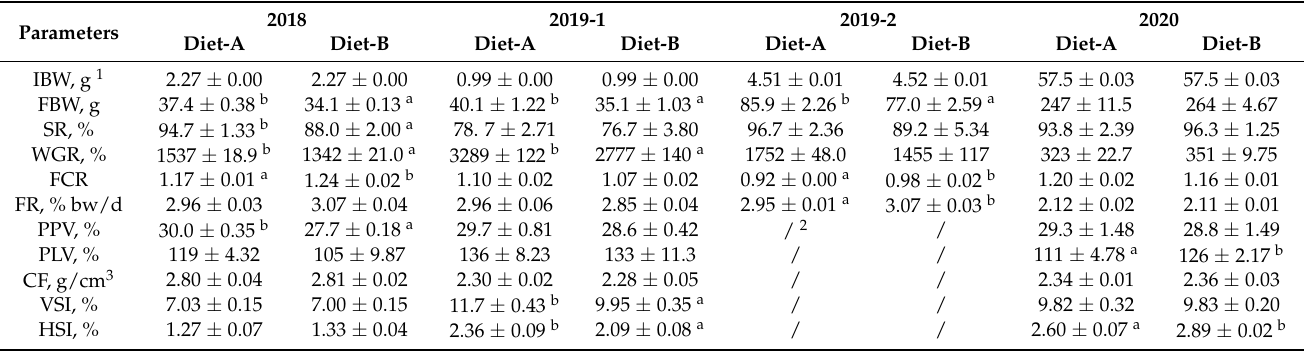
Table 6. Effects of dietary soybean meal (SBM) prepared with two different soybean sources on the growth performance and morphometric parameters in Nile tilapia with various initial body weights (means ± SEM, n =